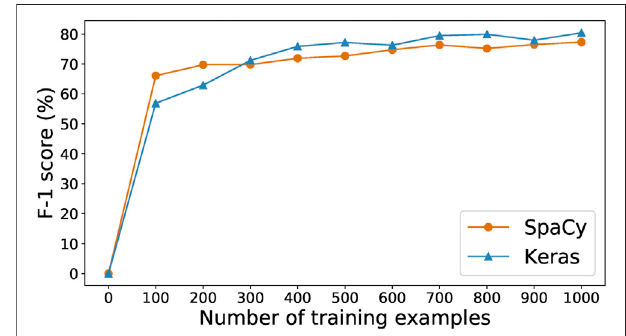
FIGURE2| Precision,recall,andF-1scoresofmediumandlargeSpaCy models trained on 278 examples.